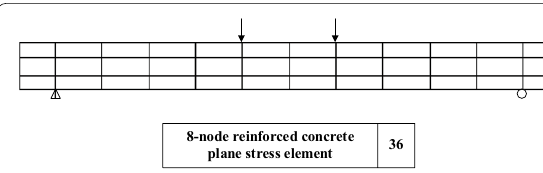
Fig. 5 Finite‑element model for deteriorated reinforced concrete beams.